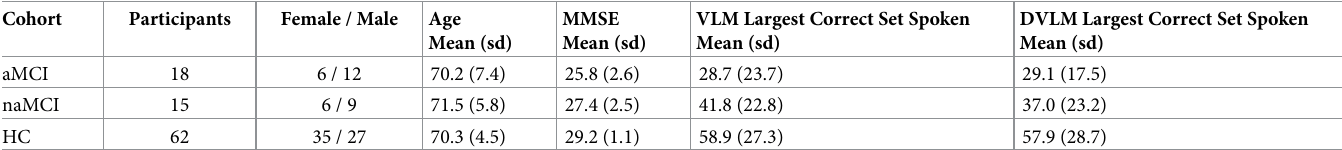
Table 1. Counts, demographics, and functional measures of study participants in the aMCI, naMCI, and HC